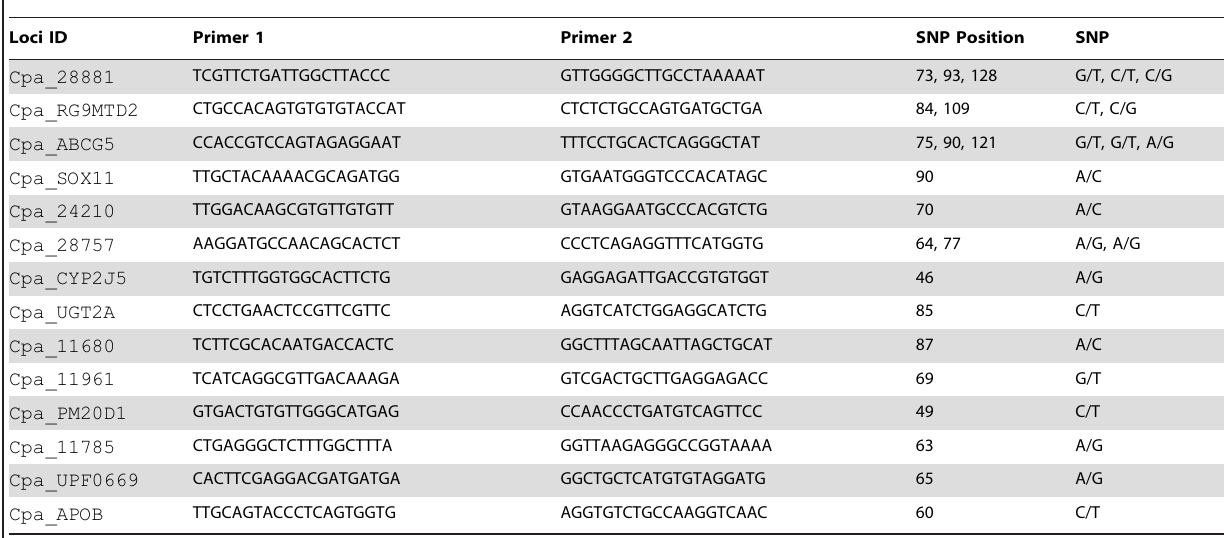
Table 2. Loci selected for HRMA and associated primers.